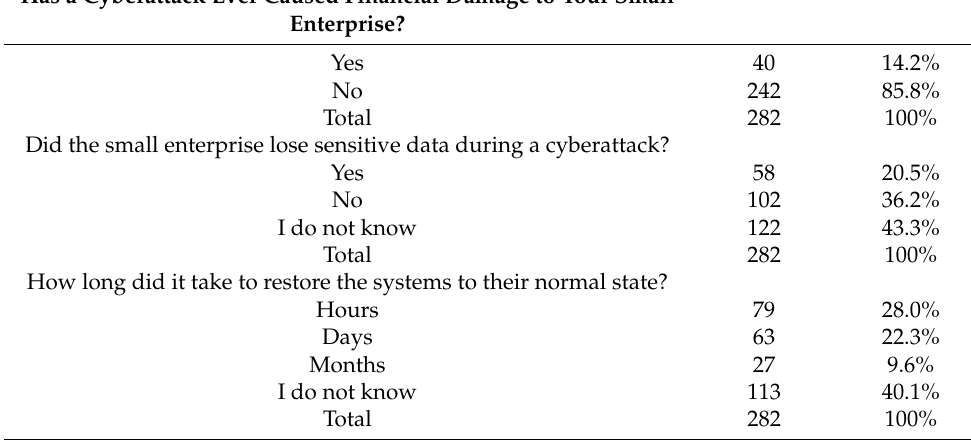
Table 3. Cybersecurity attacks.